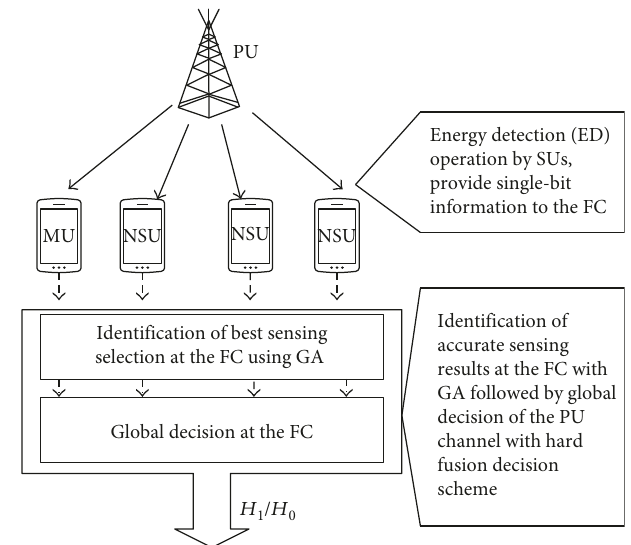
Figure 2: The proposed CSS